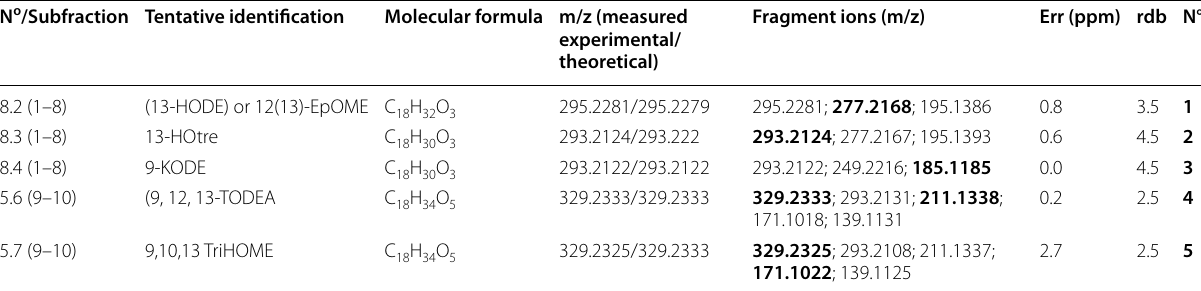
Table 1 Characterization of compounds of ethanolic extract from F. rugosa by UPLC‑QTof‑MS a